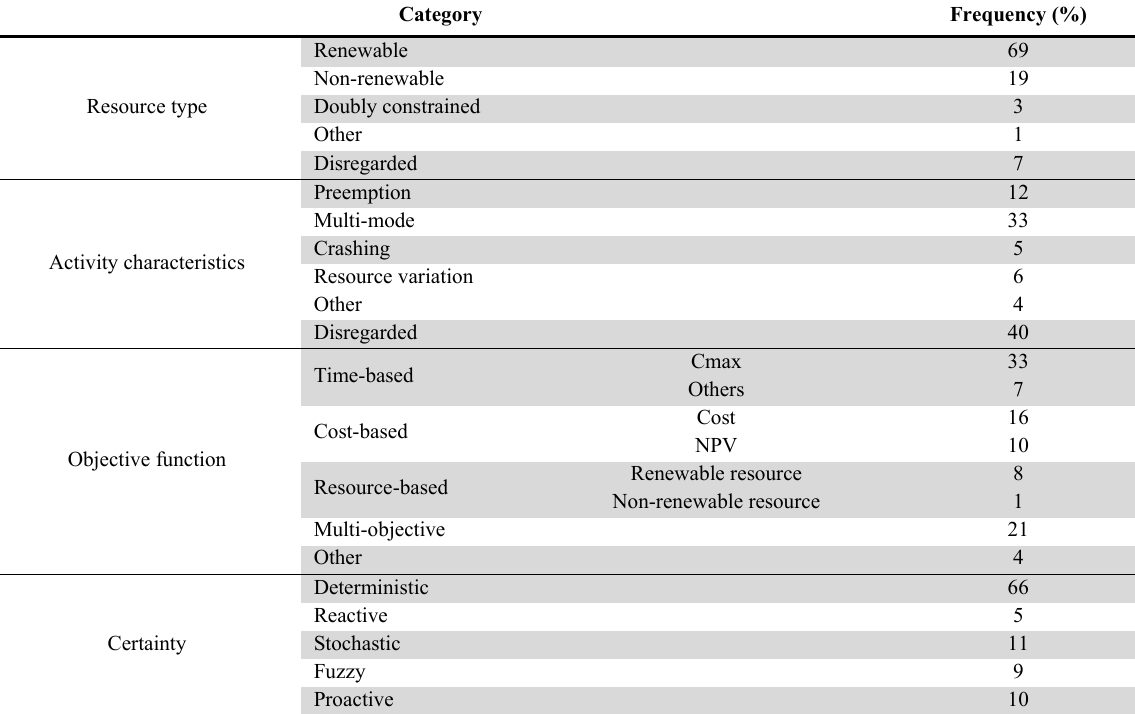
Frequency of each